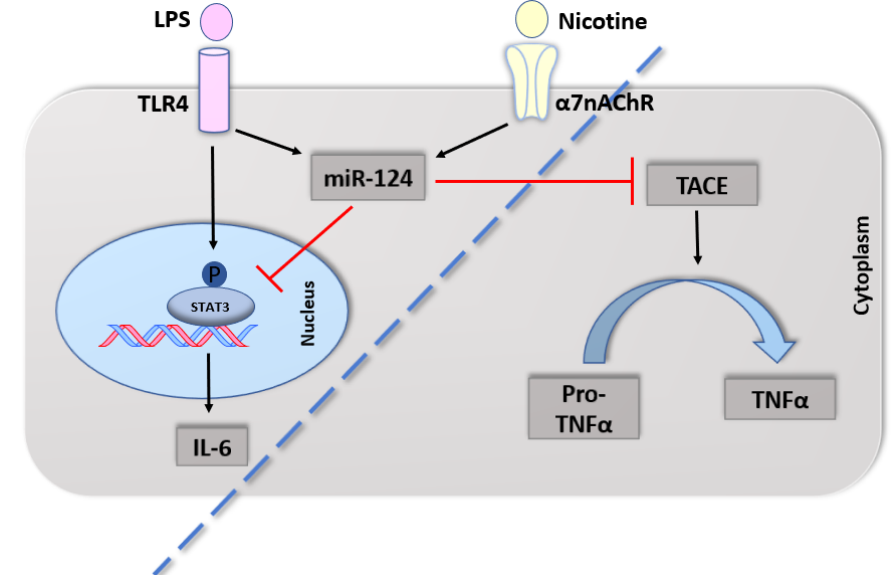
Figure 3. Nicotine activates the anti-inflammatory response in UC macrophages. Nicotine through its receptor, α 7nAChR, upregulates miR-124 in LPS-induced macrophages. MiR-124 in turn targets phosphorylated STAT3 and decreases production of IL-6 at the transcriptional level. Meanwhile at the post-transcriptional level, miR-124 blocks TACE, resulting in interruption of TNF α maturation mimicking UC macrophages. Interrupted line to separate cytoplasmic event from nucleic one. STAT3: Signal transducer and activator of transcription 3, TACE: Tumor necrosis factor (TNF)-alpha converting enzyme.